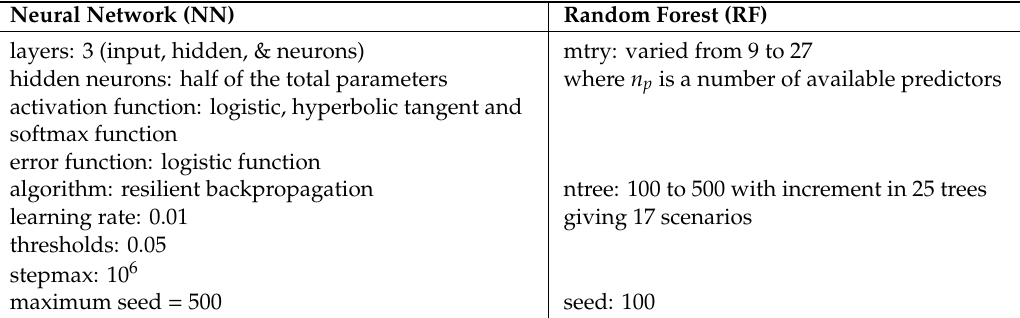
Table 1. Inherent parameters set for the neural network (NN) and random forest